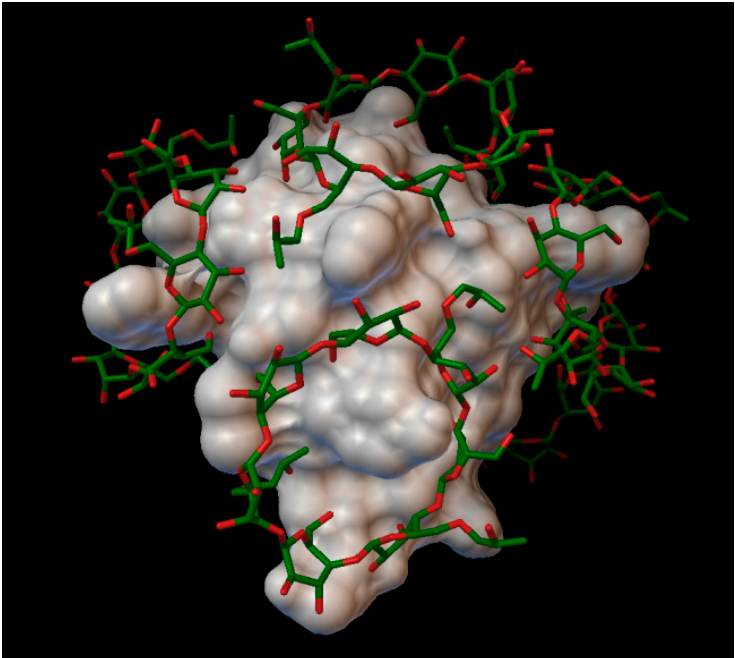
Figure 10. Insulin-hydroxypropyl- β -cyclodextrin (DS 3) complex. The insulin molecular surface is marked with white and the cyclodextrin molecules are marked with with green and red licorice.